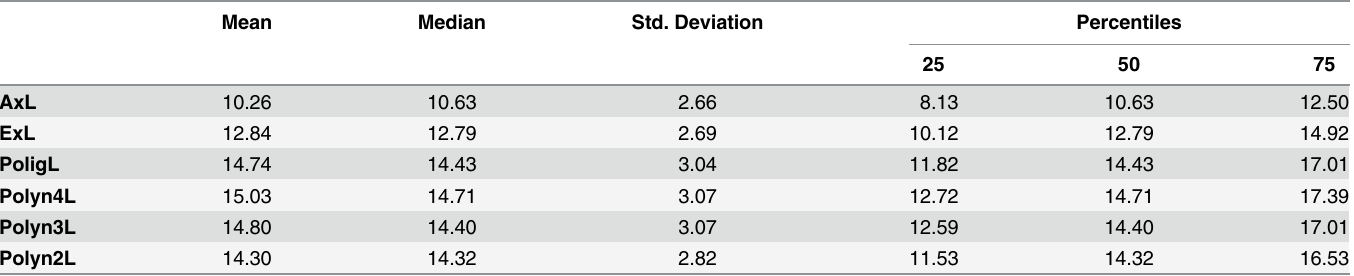
Table 2. Descriptive data for NLC length measurements.